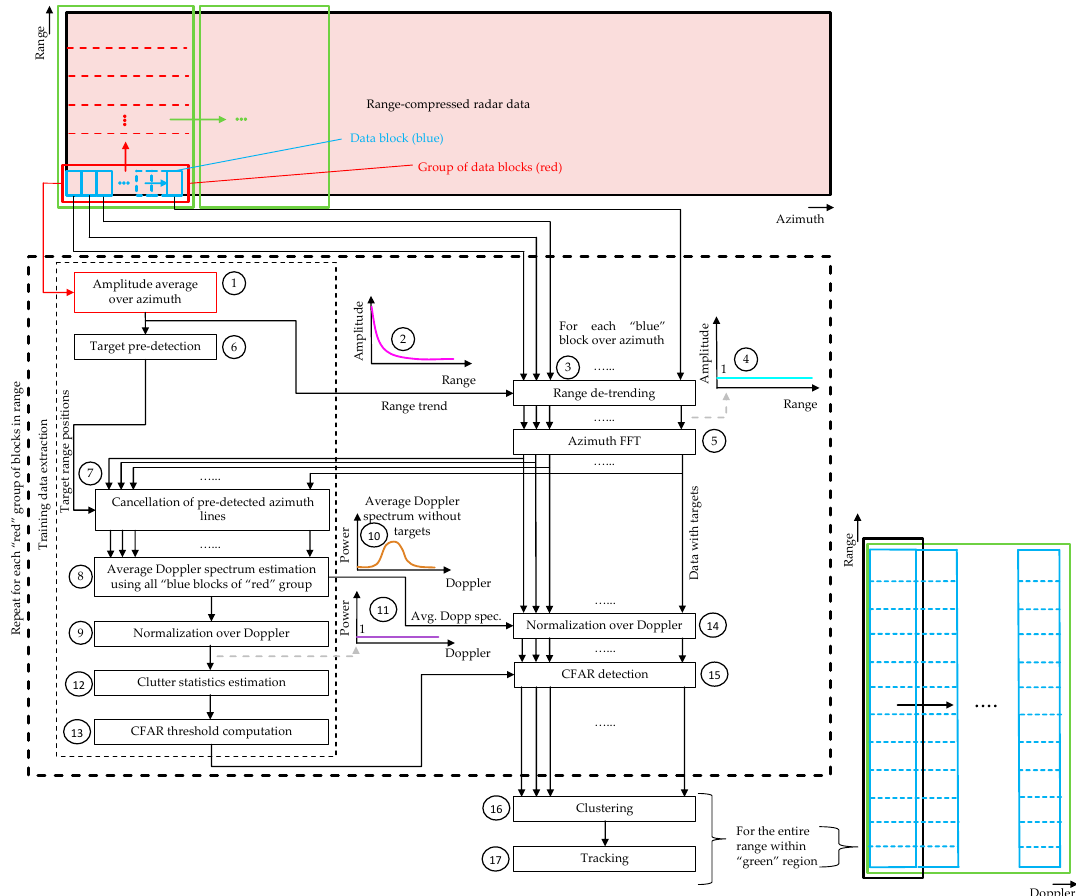
Figure 4. Block diagram of the proposed algorithm which uses RC airborne radar data as input. The individual blocks and processing steps are numbered from 1 to 17 and are discussed in detail in the text. In Error! Reference source not found. , the RC radar data (top) are initially divided into “green” regions, where each green region is further partitioned along range into “red” sub-regions. Each red sub-region consists of a group of “blue” data blocks where each data block consists of a certain number of azimuth samples commonly known as coherent processing interval (CPI). The selection of the optimum number of azimuth samples is system dependent. For the F-SAR system, the typical acquisition geometry and the pulse repetition frequency (PRF) of 2400 Hz, we found that 128 azimuth samples per CPI are well suited. First, an average amplitude profile over azimuth is estimated for a red sub-region (labelled with (1) in Error! Reference source not found. ). A trend along range is derived after performing median filtering (2). Then, for each blue data block this median filtered range trend is used for performing range de-trending (3). This is important for normalizing the range varying amplitude of the data to a constant value (4). After range de-trending, each data block is transformed into range- Doppler domain by performing an azimuth FFT (5). From the “target pre-detection” module (6), the azimuth lines corresponding to “potential targets” at certain range positions are detected and cancelled in range-Doppler domain for each data block of the red sub-region (7). More details on the significance of target pre-detection and the proposed method are presented in section 3.1. Afterwards, an average Doppler spectrum without target signals is estimated using all data blocks (8).